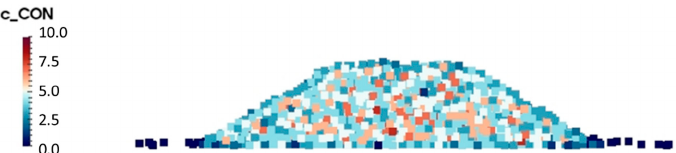
Figure 10. Coordination number of a vertical cross-section of the simulated pellet pile.